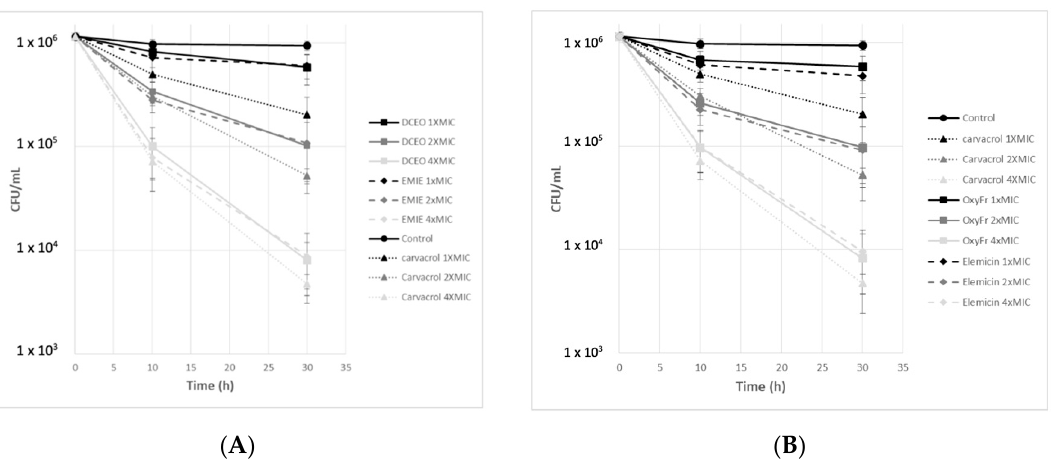
Figure 1. Rapid bactericidal effect of the DCEO and its active molecules against mid-log grown cells of C. jejuni F38011 using time kill assays for 30 min with concentrations corresponding to MIC, 2 × MIC, and 4 × MIC. Control cells were treated with DMSO and carvacrol was used as a positive standard. ( A ) effect of the entire DCEO and EMIE. ( B ) effect of Oxy-Fr and Elemicin. Data are the means ± SEM from three independent experiments.